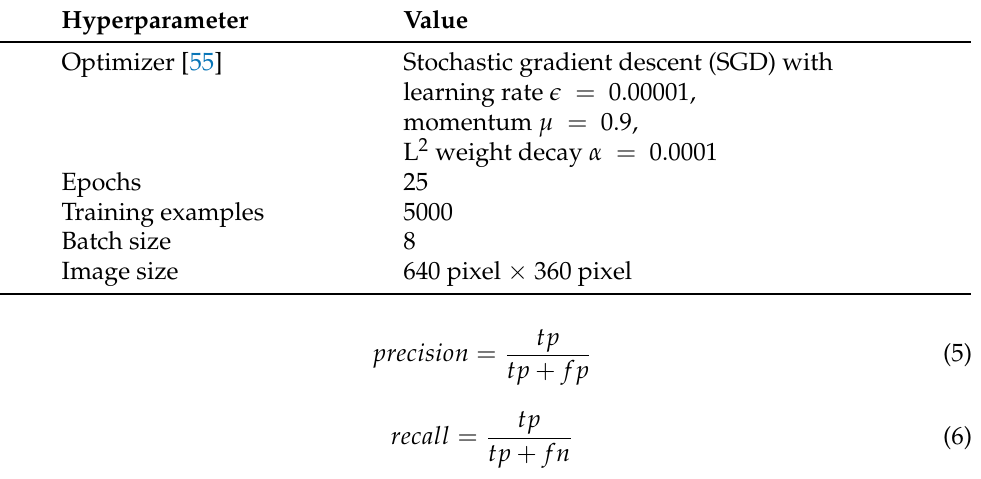
Table 2. Deep learning